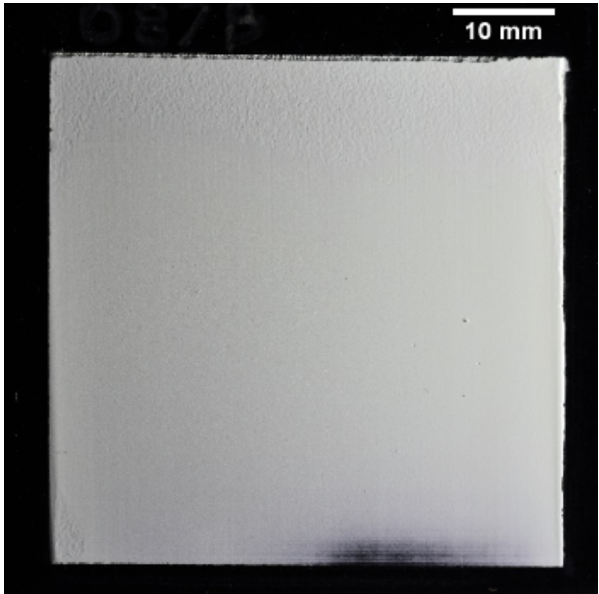
Figure 2. Wedged 6 LiF:ZnS scintillator photograph with oblique lighting to emphasize surface texture. Measured scintillator thickness at the top of the screen is 326 μ m and decreases to nominally 0 μ m at the bottom of the screen.